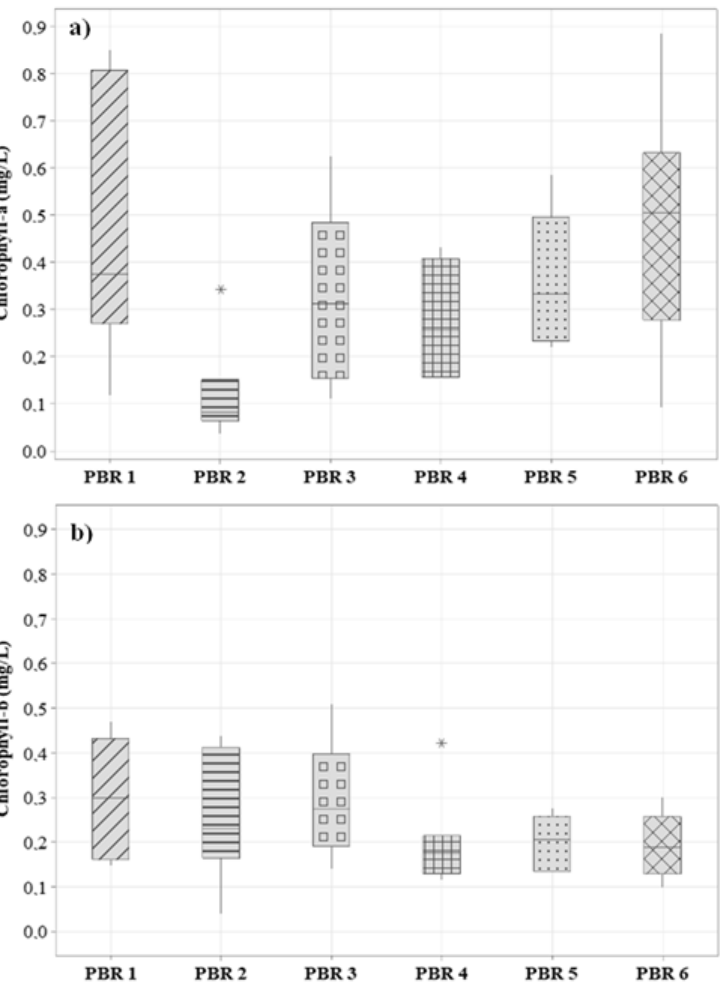
Figure 5. Variation of the concentration of ( a ) chlorophyll-a and ( b ) chlorophyll-b during the operational period.